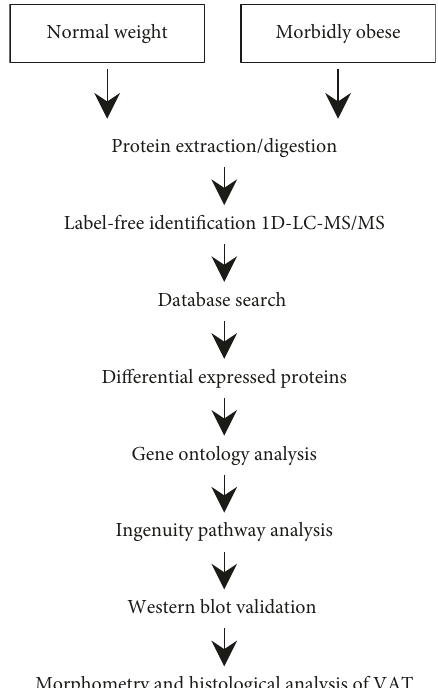
Figure 1: Workflow of the label-free 1D-LC/MS/MS proteomic strategy. In this work, visceral adipose tissue samples of 9 morbidly obese Chinese women and samples of 8 normal weight controls were extracted, pooled, and digested. The peptides were then se- quenced using 1D-LC/MS/MS and label-free proteomic analysis. Technical replicates of mass spectrometry measures were con- ducted three times. GO analysis and IPA were used to analyze biological functions and pathways. Three candidate proteins were selected and further validated by western blotting analysis. Mor- phometry and immunohistochemical analyses were conducted between the two groups. Abbreviations: GO, Gene Ontology. IPA, Ingenuity Pathway